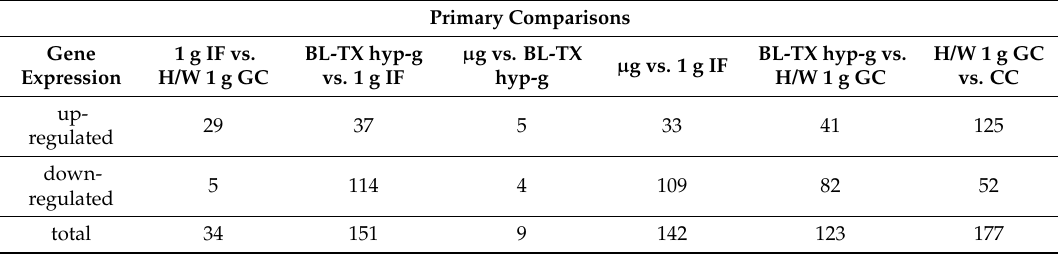
Table 5. Identification of hyper- and microgravity-sensitive probe sets representing genes involved in HIF-1 signaling pathway in response to altered gravity conditions during TEXUS-51 sounding rocket flight in Jurkat T cells.